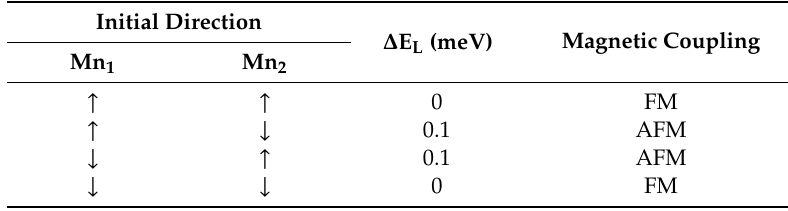
Table 1. The energy di ff erence between antiferromagnetic (AFM) and ferromagnetic (FM) states, and the corresponding magnetic coupling of di ff erent initial spin configurations on Mn atoms of the Mnq 2 monoclinic